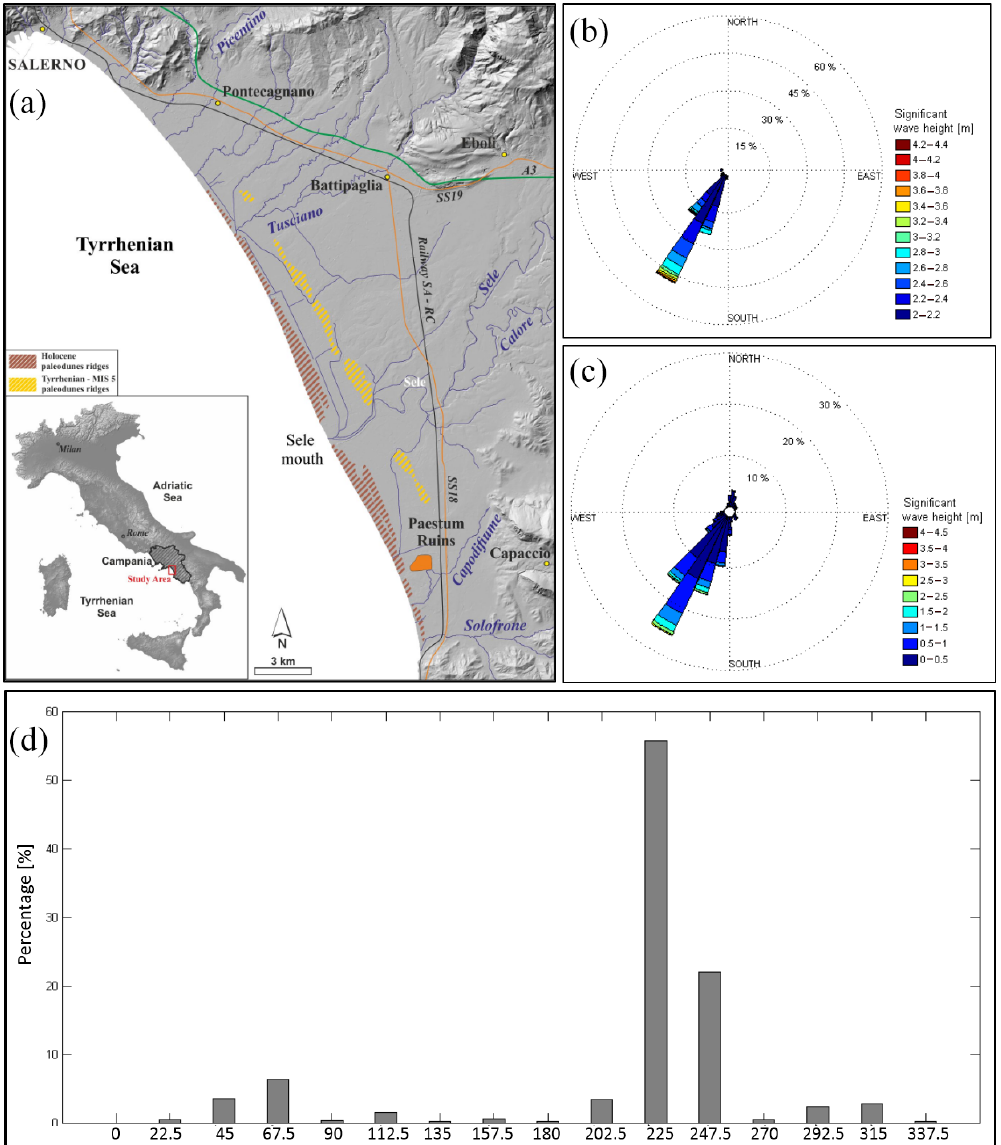
Figure 1. Location map of coastal Sele Plain (a) ; directional distribution of the H s (b) and of the H s ≥ 2m recorded by Salerno buoy in the 2014–2016 years (c) ; H s occurrence probability (%) for each direction (d)